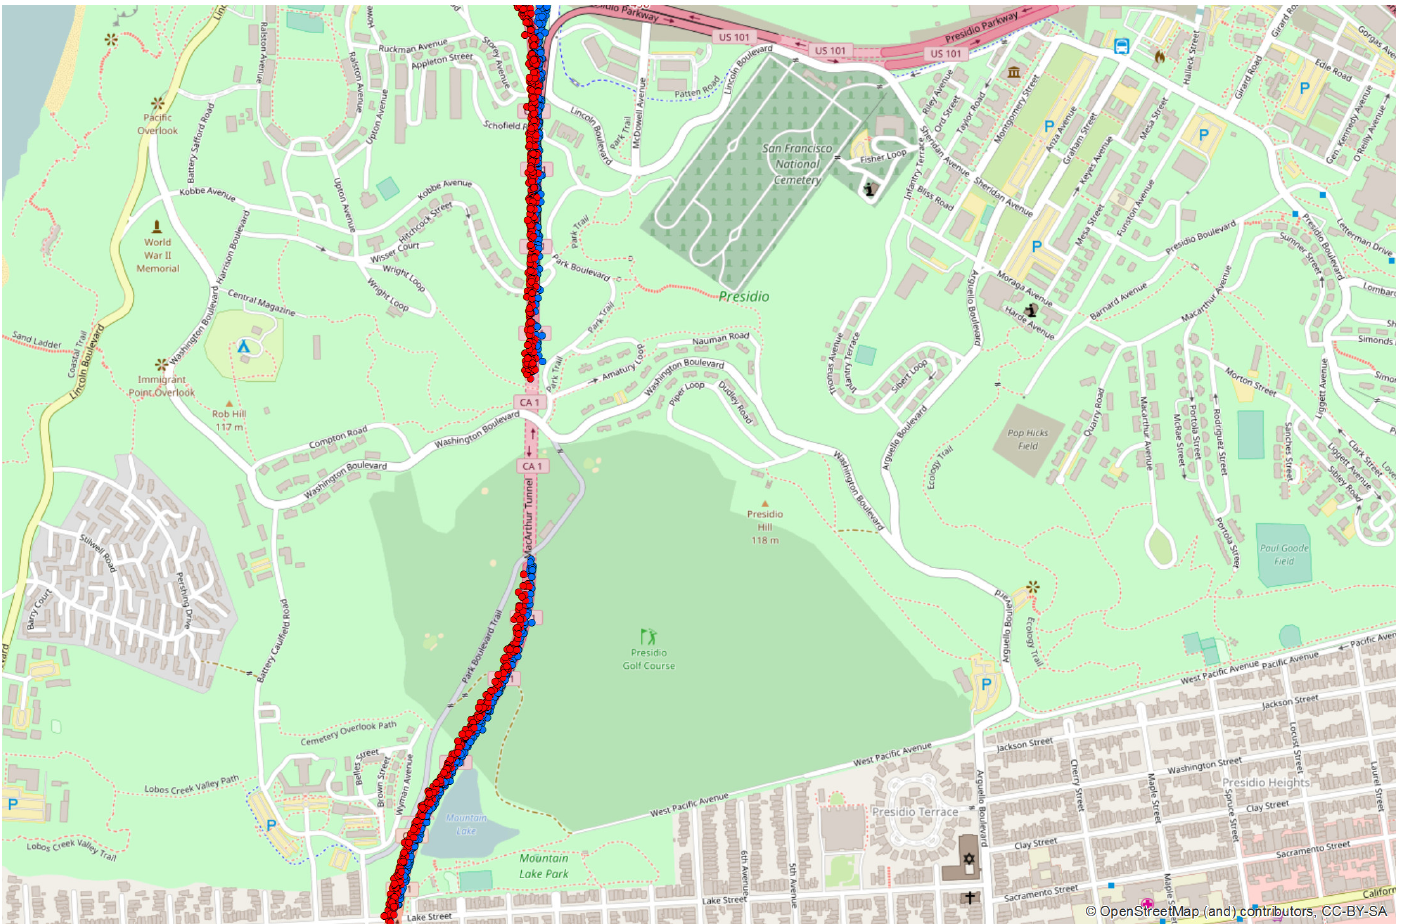
Figure A1. Douglas Mc Arthur Tunnel, São Francisco